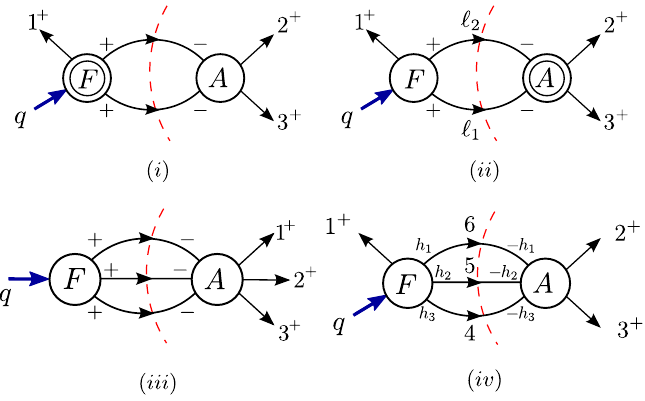
Figure 1 . Four unitarity cuts used to construct the integrand for the two-loop form factor of F O (1 + ; 2 + ; 3 + ; q ). Cut (i) and (iii) are both operator- and theory-independent. Cut (ii) S ; O C